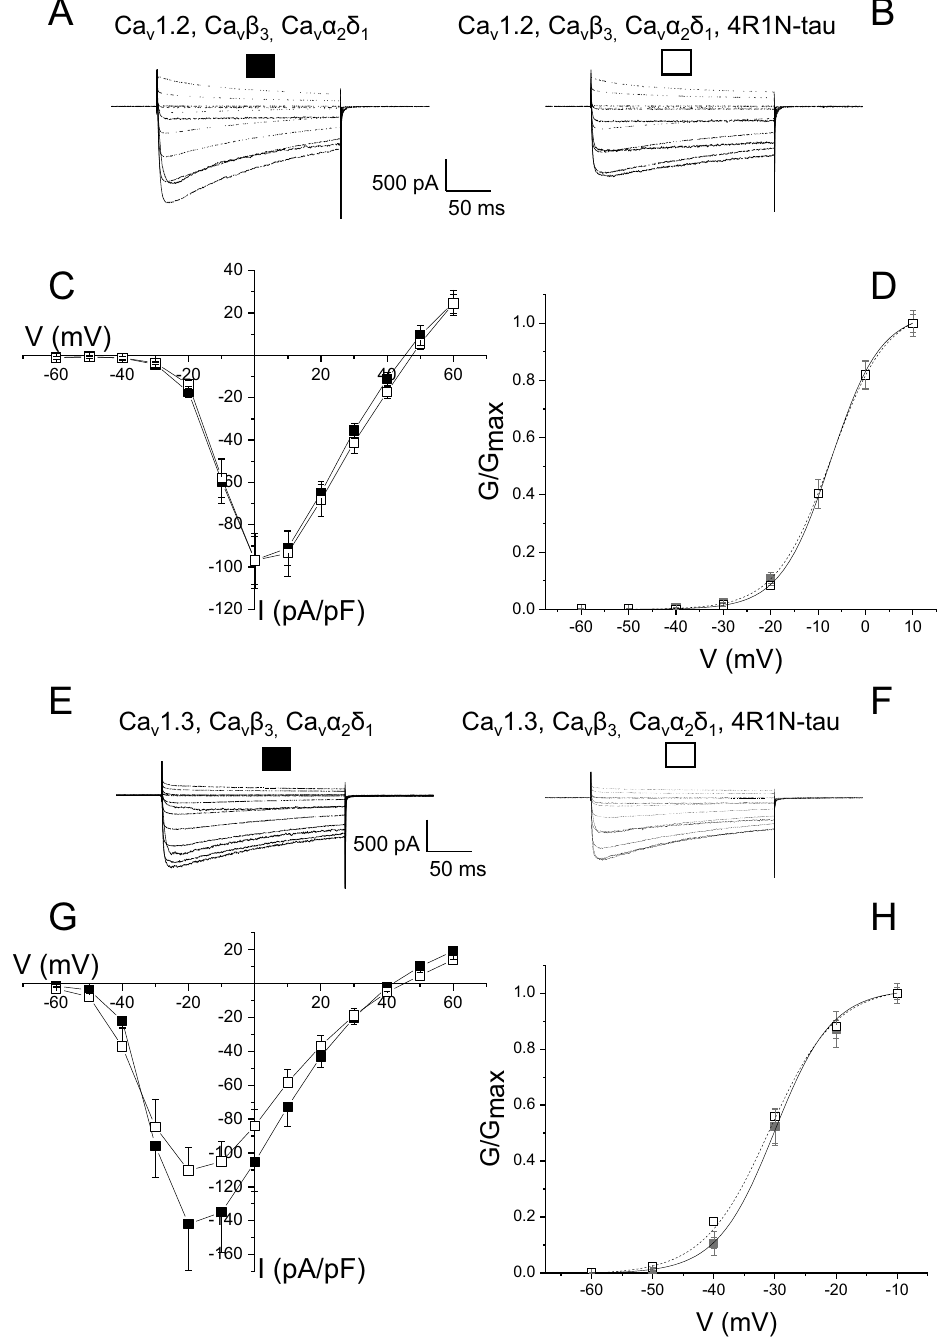
Figure 7. Co-expression of 4R1N-tau has no effect on L-type current. ( A,B ) Co-expression of 4R1N-tau in tsA-201 cells had no effect on macroscopic Ca v 1.2, Ca v β 3 , and Ca v α 2 δ 1 -mediated current evoked from a holding potential of − 90 mV. Co-expression of the 4R1N-tau isoform had no effect on the current–voltage relationship ( C ) or activation curve ( D ) for the current. ( E , F ) In contrast, co-expression of 4R1N-tau caused a non- significant reduction in the amplitude of Ca v 1.3, Ca v β 3 , and Ca v α 2 δ 1 -mediated current evoked from a holding potential of − 90 mV ( E , EGFP-expressing cells − 146.2 ± 26.2 pA/pF (n = 8), F , 4R1N-tau-expressing cells − 114.0 ± 14.6 pA/pF (n = 8) (t = 1.05, p = 0.30)). ( G ) Current–voltage relationship showing the small reduction in amplitude of